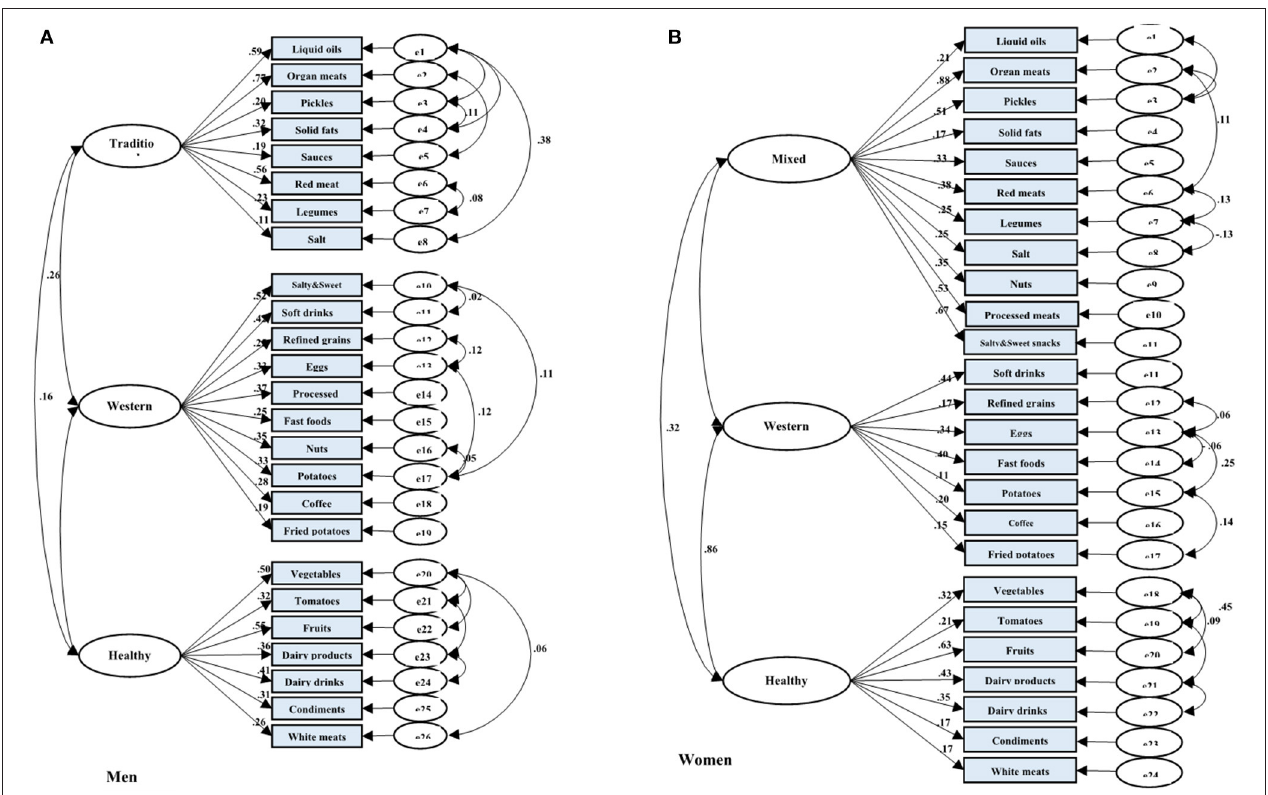
FIGURE 2 | Results of the Confirmatory Factor Analysis (CFA) of the latent variables of dietary patterns and their indicator variables (food groups) among adults from AmolCS, Iran; (A) Men and (B) Women. Fit indices of measurement model of dietary patterns in (A) men: GFI = 0.94, AGFI = 0.92, SRMR = 0.05, RMSEA = 0.05, and in (B) women: GFI = 0.92, AGFI = 0.89, SRMR = 0.06, RMSEA = 0.05. Boxes indicate observed variables, and ellipses are latent variables in the model. All factor loadings and regression coefficients in the figure are standardized and have a p <